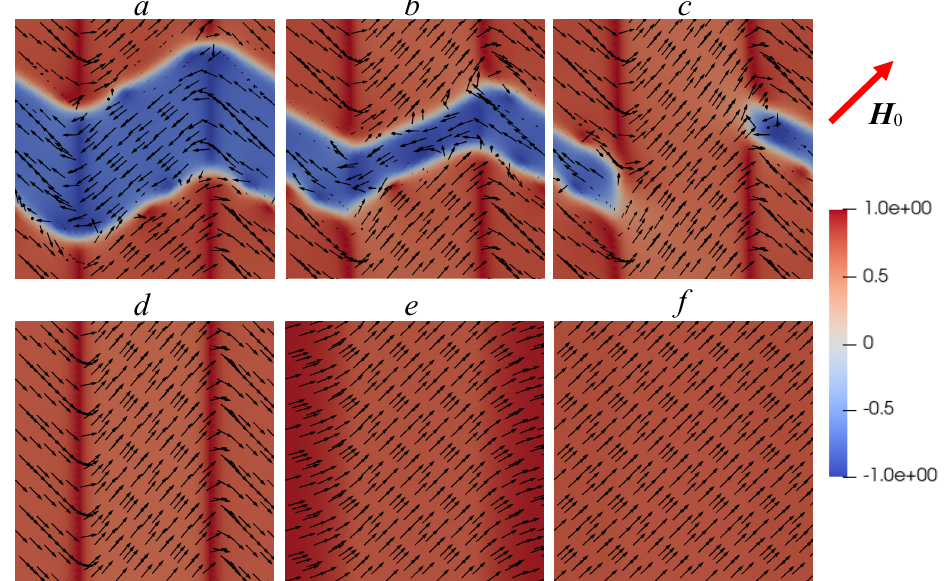
Figure 6. Evolution of the magnetization vector when an external magnetic field is applied at an angle of 45.84 ◦ to the y axis: ( a )— ˜ H 0 = 0, ( b )— ˜ H 0 = 0.15, ( c )— ˜ H 0 = 0.16, ( d )— ˜ H 0 = 0.17, ( e )— ˜ H 0 = 1.1, ( f )— ˜ H 0 =